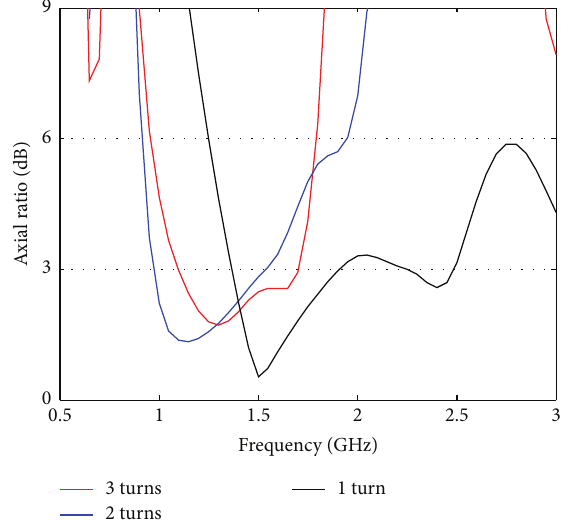
Figure 3: Axial ratio against frequency of the strip-helical antennas with different turn